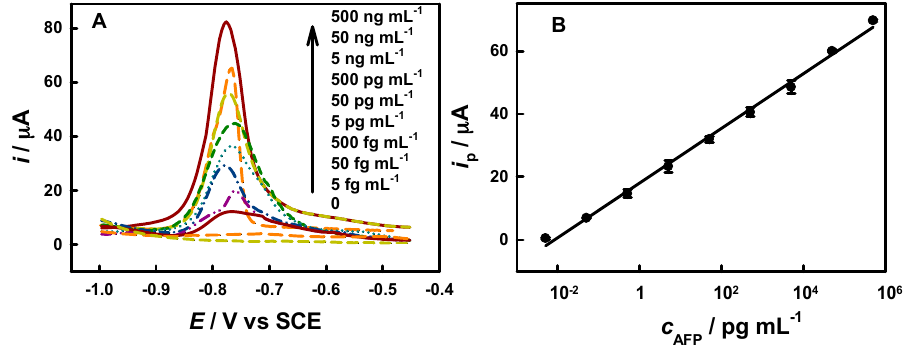
Figure 4. Differential pulse ASV curves for AFP immunoassay ( A ) and corresponding calibration curves ( B ) by our protocol ( n = 3).